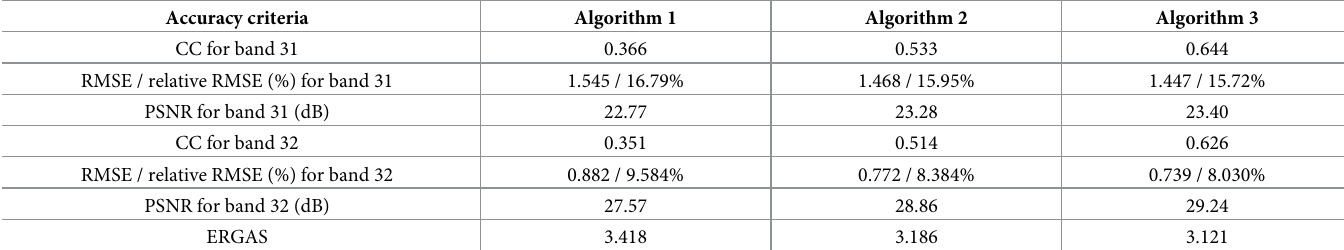
Table 2. Correlation Coefficient (CC), Root Mean Squared Error (RMSE), and Peak Signal-to-Noise Ratio (PSNR) for each band [31, 32], and Relative Dimension- less Global Error (ERGAS) between the results from the three types of super-resolution algorithms and ASTER radiance. CC and PSNR: larger is better; RMSE and ERGAS: smaller is better.